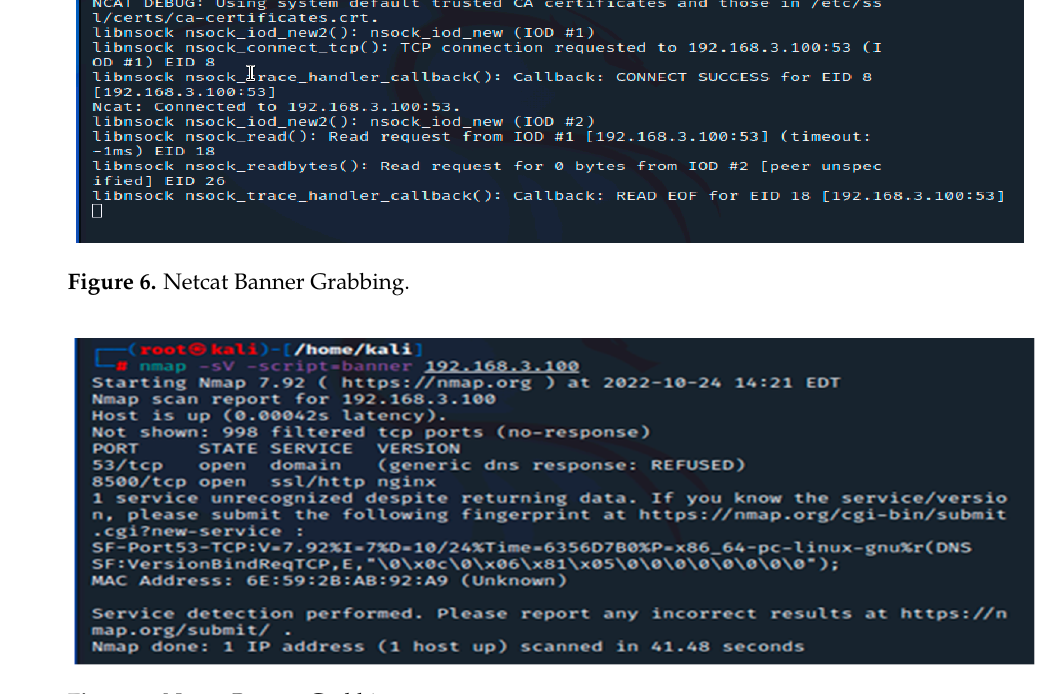
Figure 7. Nmap Banner Grabbing.